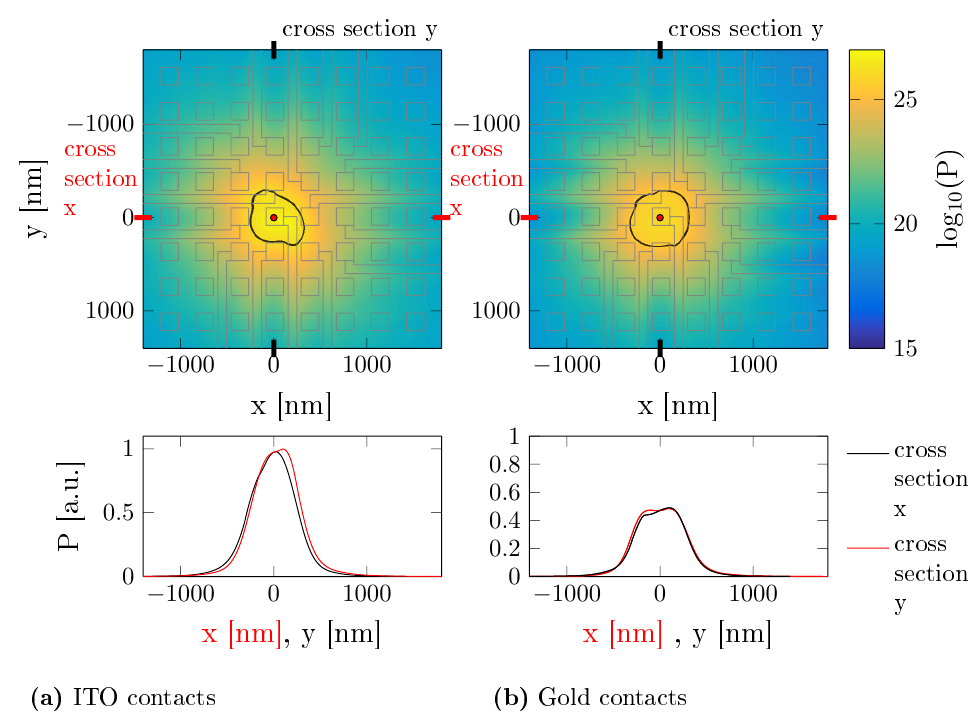
Figure 3. Logarithm of electromagnetic field intensity in the xy plane for the directly addressed array, 100 nm above the top surface of the LEDs. The black lines indicate the iso-intensity curves at half of the maximal value. The gray lines show the alignment of LEDs and corresponding contacts. ( a ) Intensity distribution for ITO contacts. ( b ) Intensity distribution for gold contacts.The plots in bottom row show the intensity along the x (red line) and y (black line) cross sections through the center of the activated LED. The values are normalized to the maximum obtained for ITO